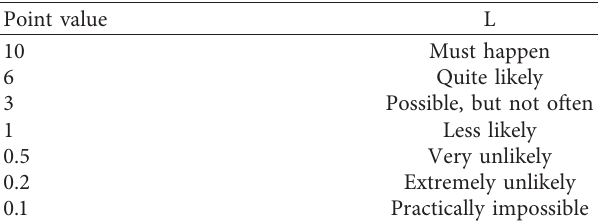
Table 1: Possibility of accident (L). Table 2: How often people are exposed to hazardous environments